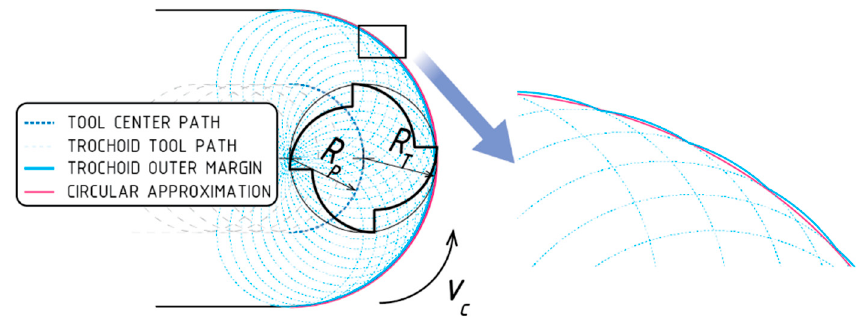
Figure 2. Geometric representation of the trochoid and circular tool paths, where: R T is the radius of the milling cutting tool; R P is the radius of the trochoid circle.